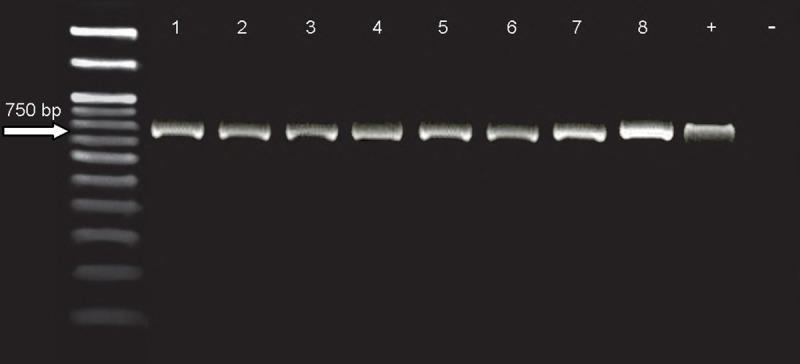
Representative agarose gel electrophoresis images.All Leishmania isolates from patients with anthroponotic cutaneous leishmaniasis areas of Kerman district were identified to be L. tropica species by nested PCR (1 and 2: Leishmania isolates from responsive patients, 3 and 4: Leishmania isolates from treatment failure patients, 5 and 6: Leishmania isolates from relapse patients, 7 and 8: Leishmania isolates from chronic patients, standard Leishmania tropica and distilled water as positive and negative controls, respectively).